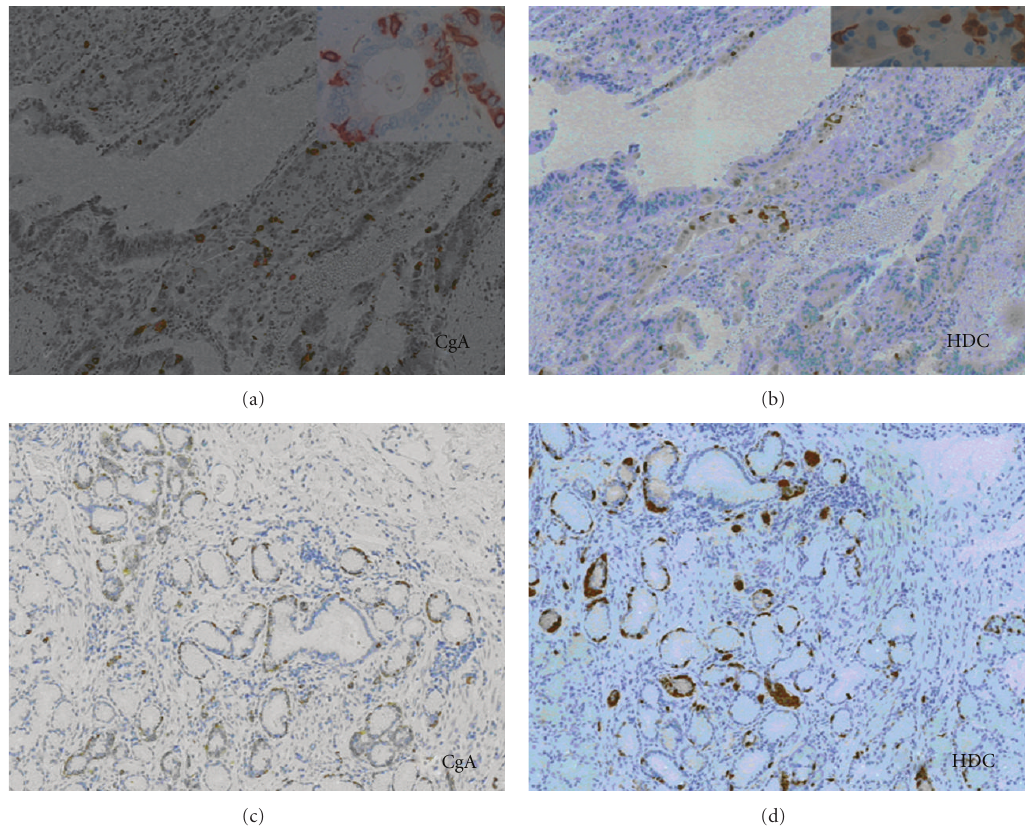
Figure 2: Immunohistochemical labelling of tumour cells in the gastric cardiac region in patient 9 demonstrating positive labelling of CgA (a and c) and HDC (b and d) (20x). Inserts